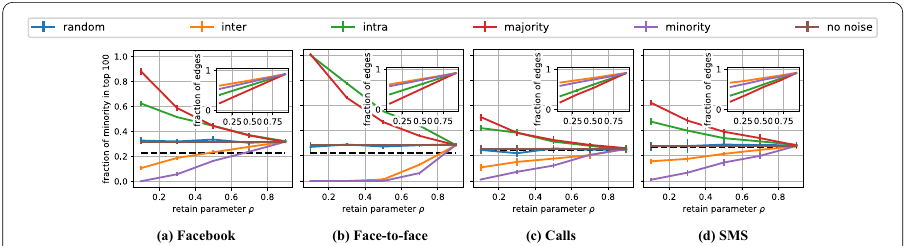
As in Table 2, we use Q mod / A to denote the modularity/assortativity of the partition based on minority and majority label. Both metrics may be interpreted as a proxy for the homophily in the dataset. The fraction of the minority in the dataset is denoted by f